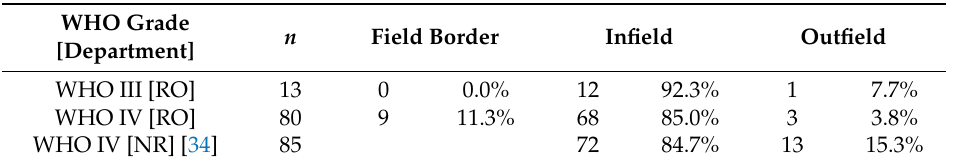
Table 1. List of recurrence patterns from glioma patients treated with radiotherapy at the Technical University of Munich (TUM). Studies were carried out independently by the Department of Radiation Oncology (RO) and the Department of Neuroradiology (NR).